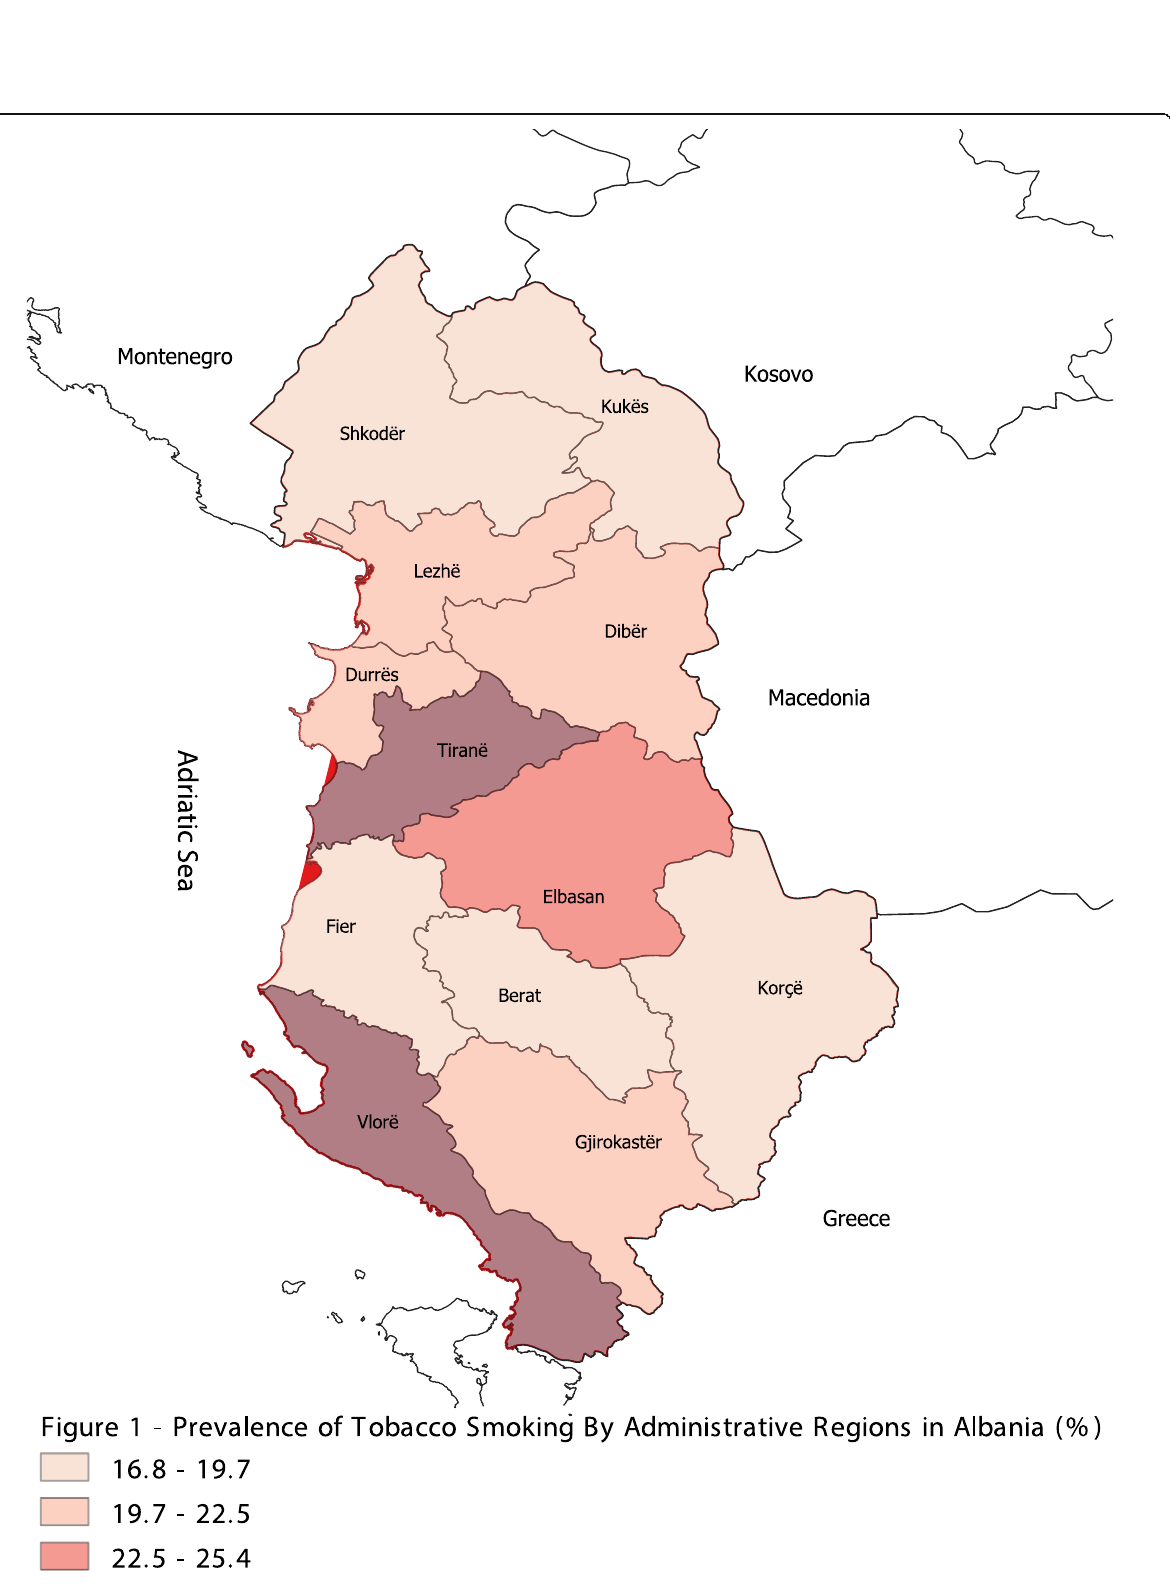
Fig. 1 Prevalence of Tobacco Smoking By Administrative Regions in Albania